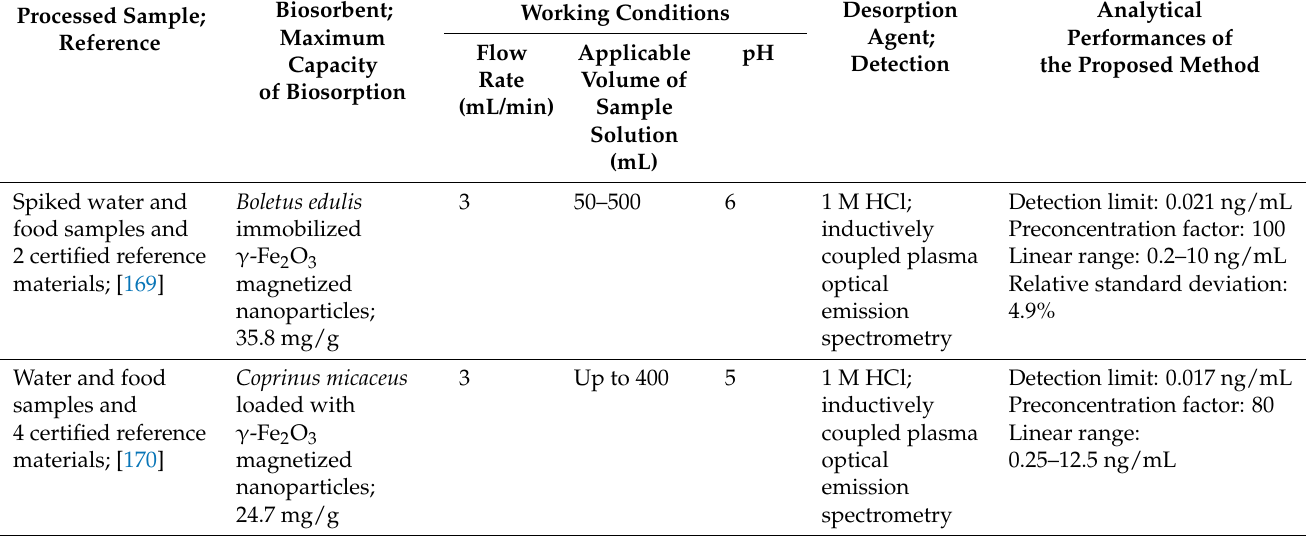
Table 7. Studies on the determination of Co(II) from real samples based on column biosorptive preconcentration in conjunction with instrumental